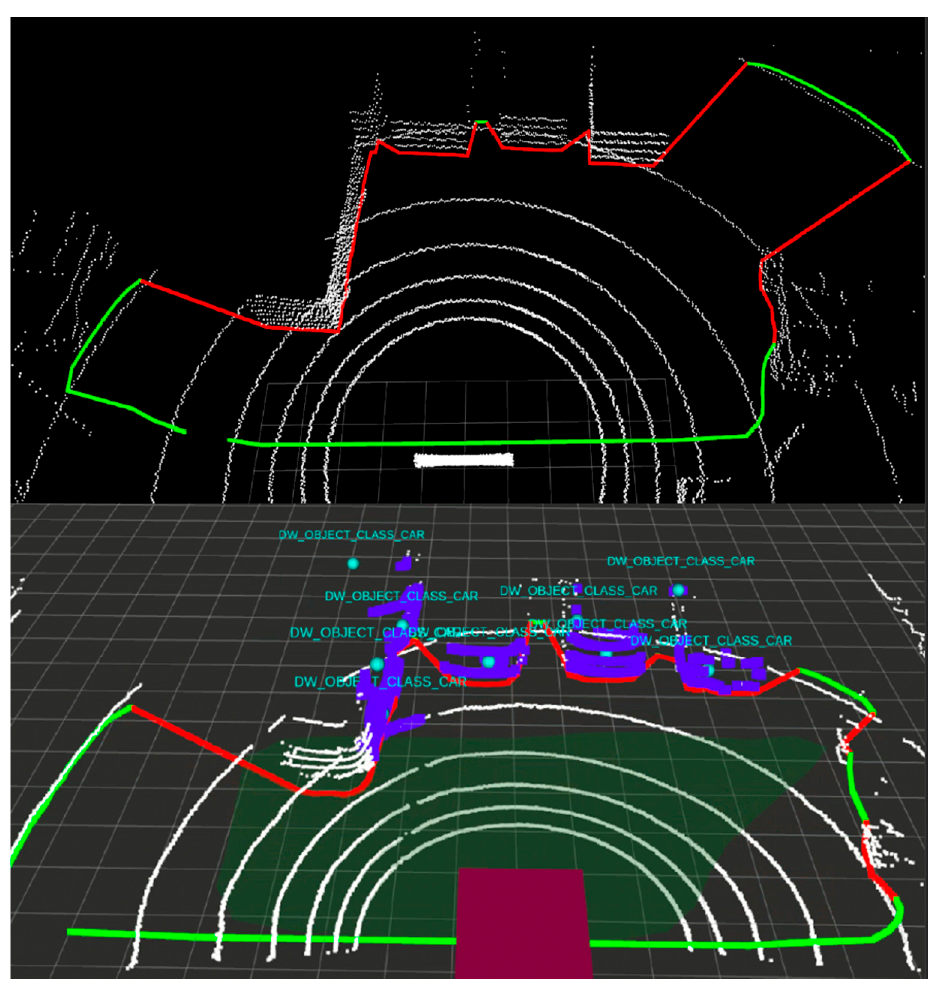
Figure 20. Comparison of Velodyne lidar with free space detection algorithm run on real and simulated data.